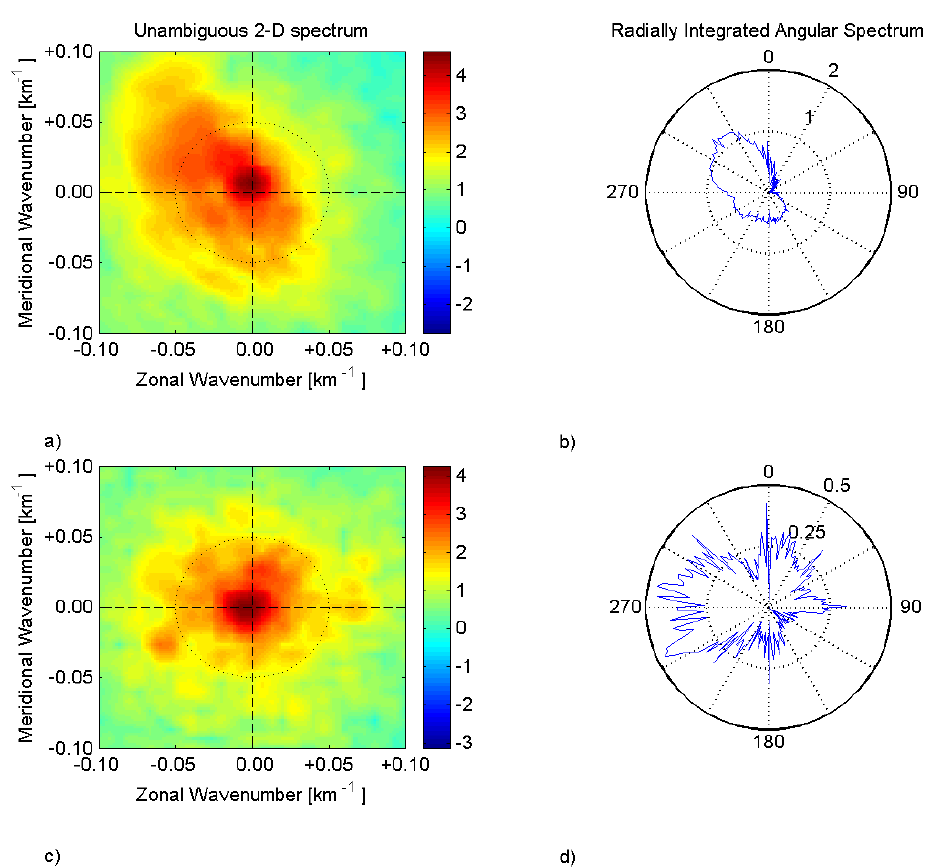
Fig. 3. The unambiguous 2-D horizontal wavenumber spectrum, (a) , and the angular spectrum, (b) , for the sequence of images acquired during the night of 28/29 July 2002 from Rothera. The scales for both spectra are logarithmic, and the 2-D spectrum is in units of (relative % wave amplitude/ wavenumber) 2 , whilst the angular spectrum has units of (relative % wave amplitude) 2 /radian. For comparison, the wavenumber spectrum, (c) , and the angular spectrum, (d) , for the same night during 2001 at Halley are